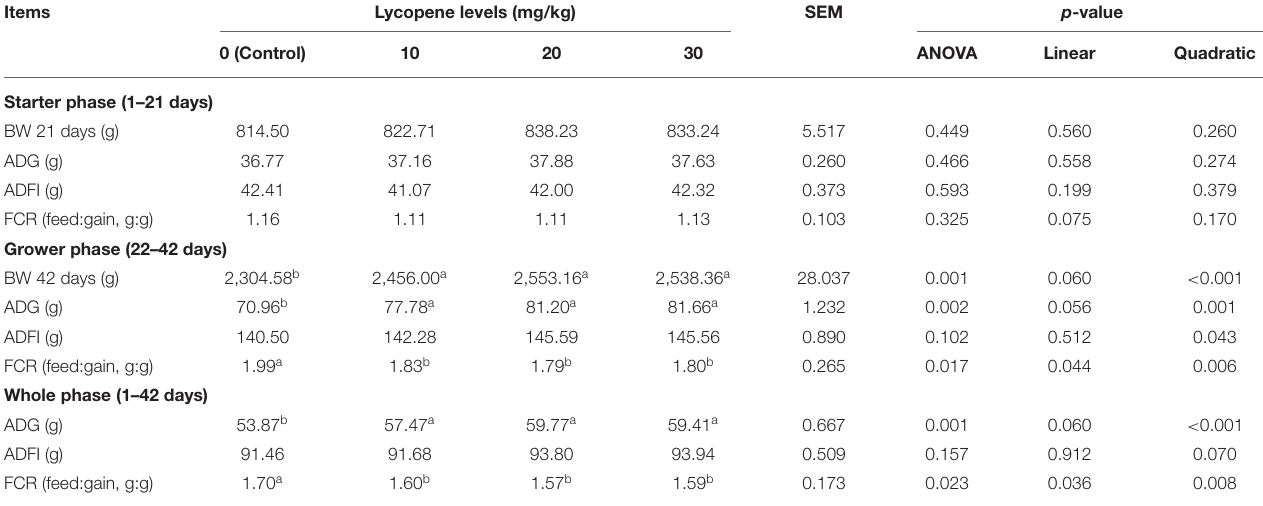
TABLE 4 | Effect of dietary lycopene levels on performance of AA broilers (1–42 days of age). Lycopene levels (mg/kg)